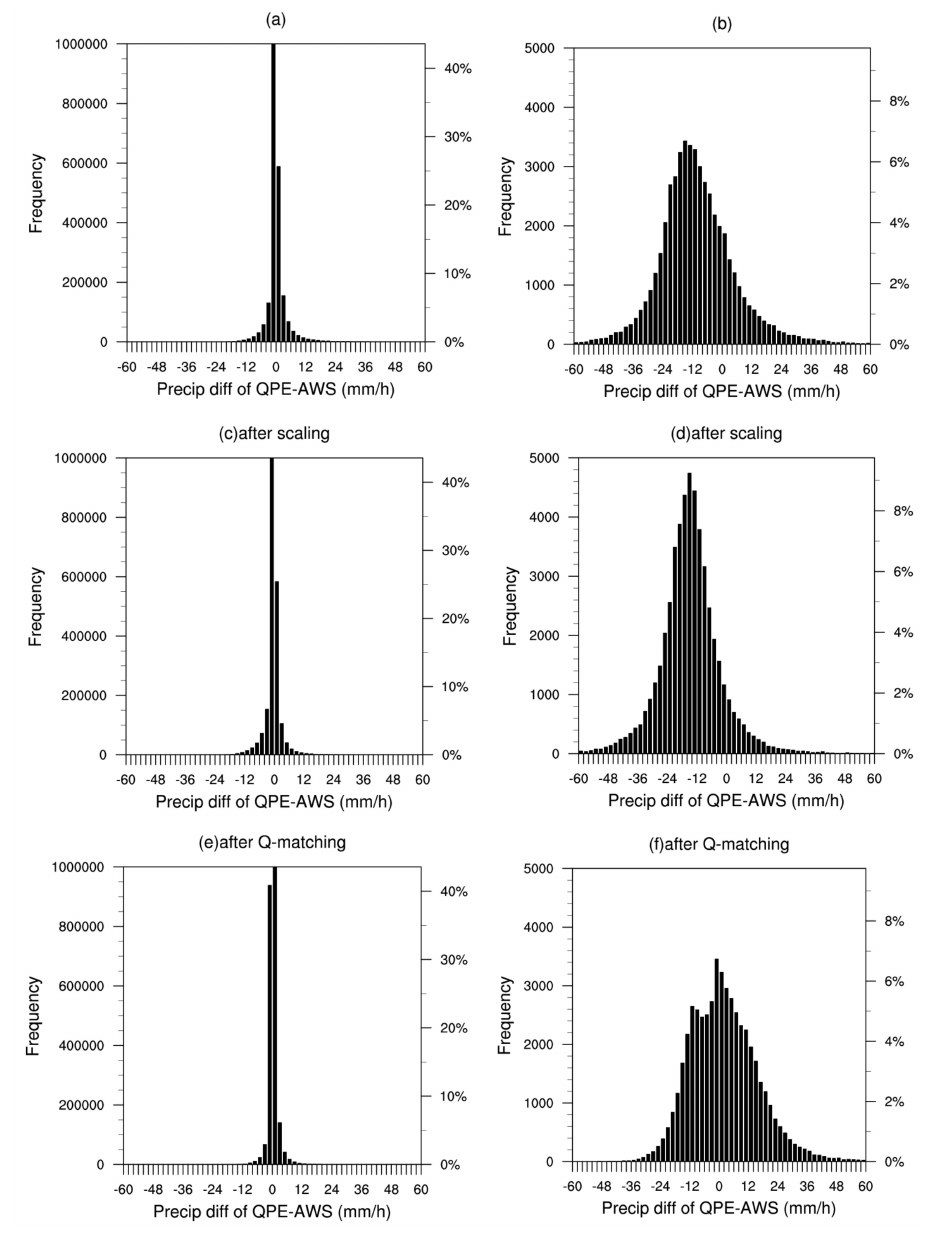
Figure 6. The probability density function of the precipitation difference between QPE and AWS for ( a , b ) original radar QPE product, ( c , d ) after correction by scaling, ( e , f ) and after correction by Q-matching. ( a , c , e ) are for hourly rainfall samples less than 20 mm/h, and ( b , d , f ) are for heavy rainfall that are larger than and equal to 20